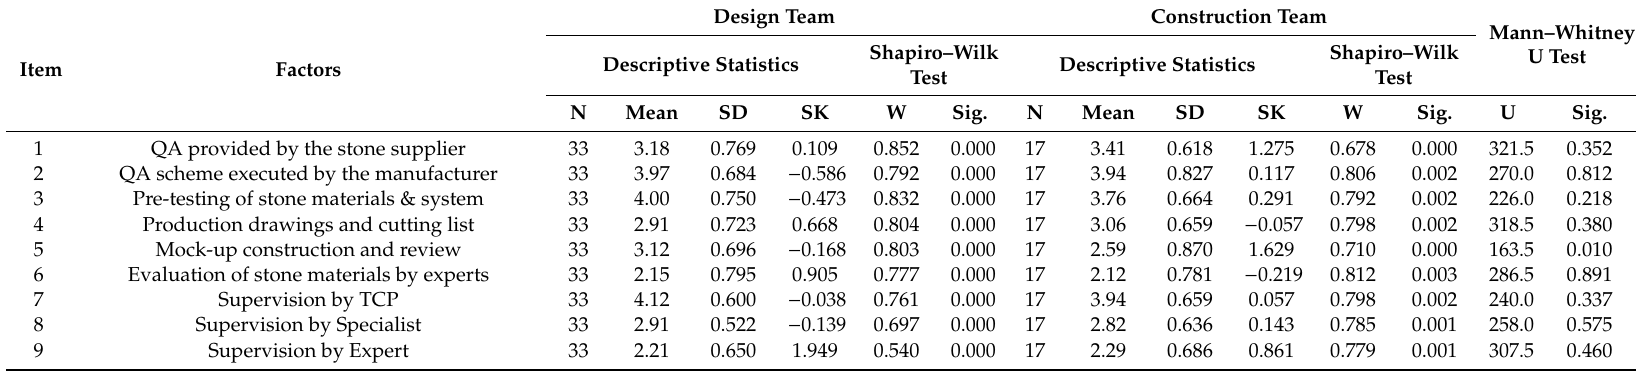
Table 3. Factors to ensure the quality in the production stage (Comparison between ‘Design Team’ and ‘Construction Team’, n =